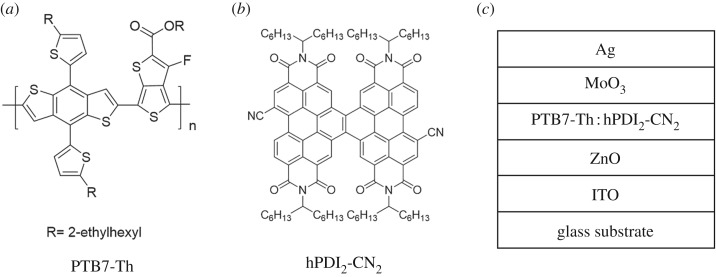
Chemical structures of PTB7-Th (a) and hPDI2-CN2 (b). (c) Inverted device structure.